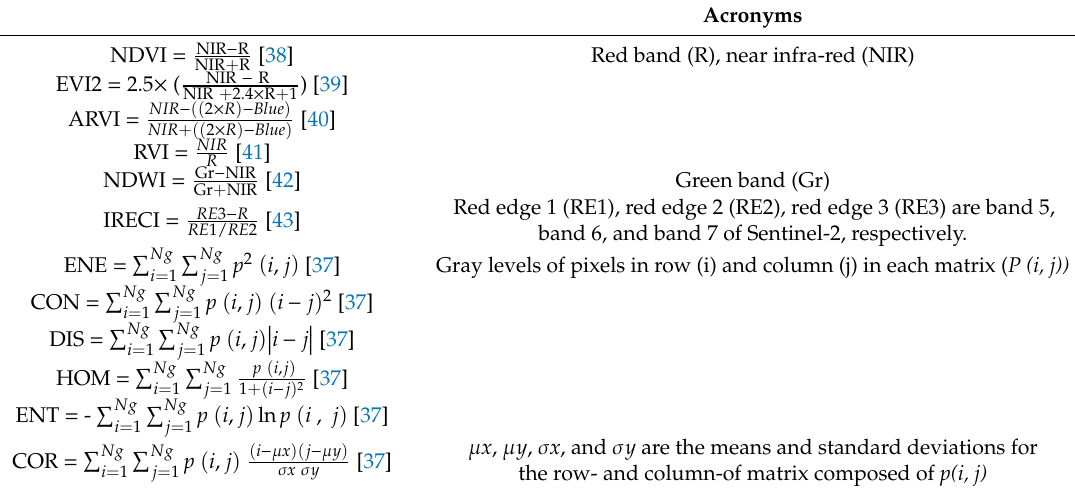
Table 3. Formula of features used in this